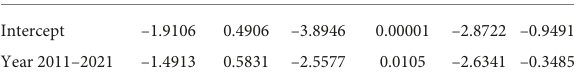
Estimate SE Z -value P -value CI.lb CI.ub